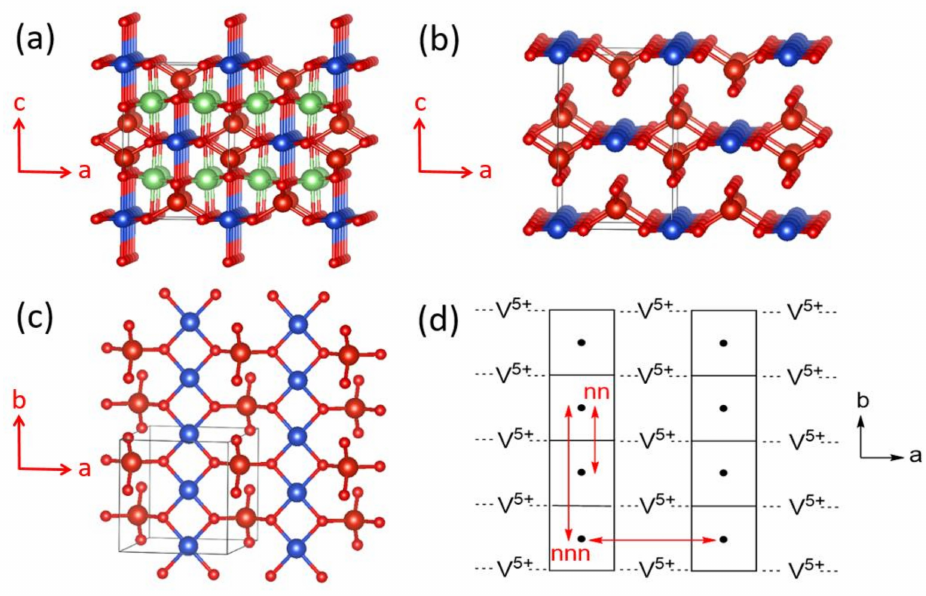
Figure 13. ( a ) The crystal structure of LiCuVO 4 viewed approximately along the b-direction, where the blue and green spheres represent the Cu and Li atoms, respectively, and the large and small red spheres represent the V and O atoms, respectively. ( b ) The CuVO 4 lattice resulting from LiCuVO 4 by removing the axial Cu–O bonds and Li atoms. ( c ) A perspective view of a single CuVO 4 layer approximately along the c-direction. ( d ) The spin exchange paths present in a single CuVO 4 layer, where the labels nn, nnn and a represent the spin exchanges J nn , J nnn and J a , respectively.